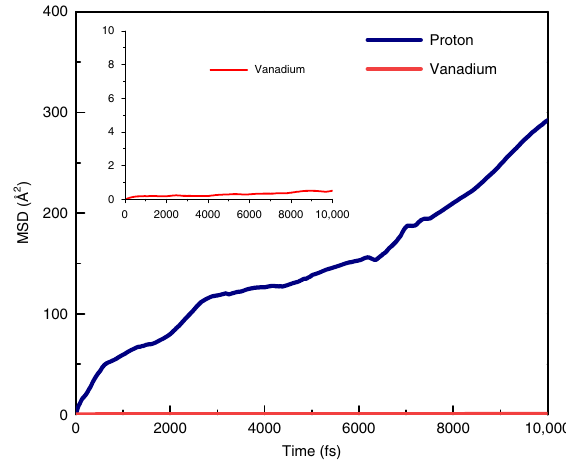
Fig. 4 Mean square displacement of proton and vanadium ion in thin- fi lm composite membranes at 298 K. Inserts are enlarged views for vanadium ion.